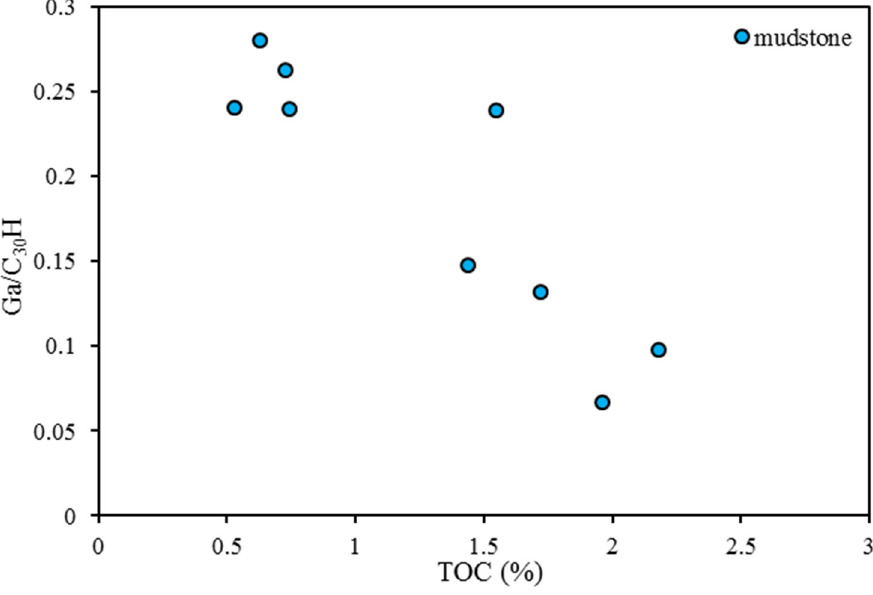
Figure 16. Relationship between Ga/C 30 H and TOC for coal ‐ measure source rocks.